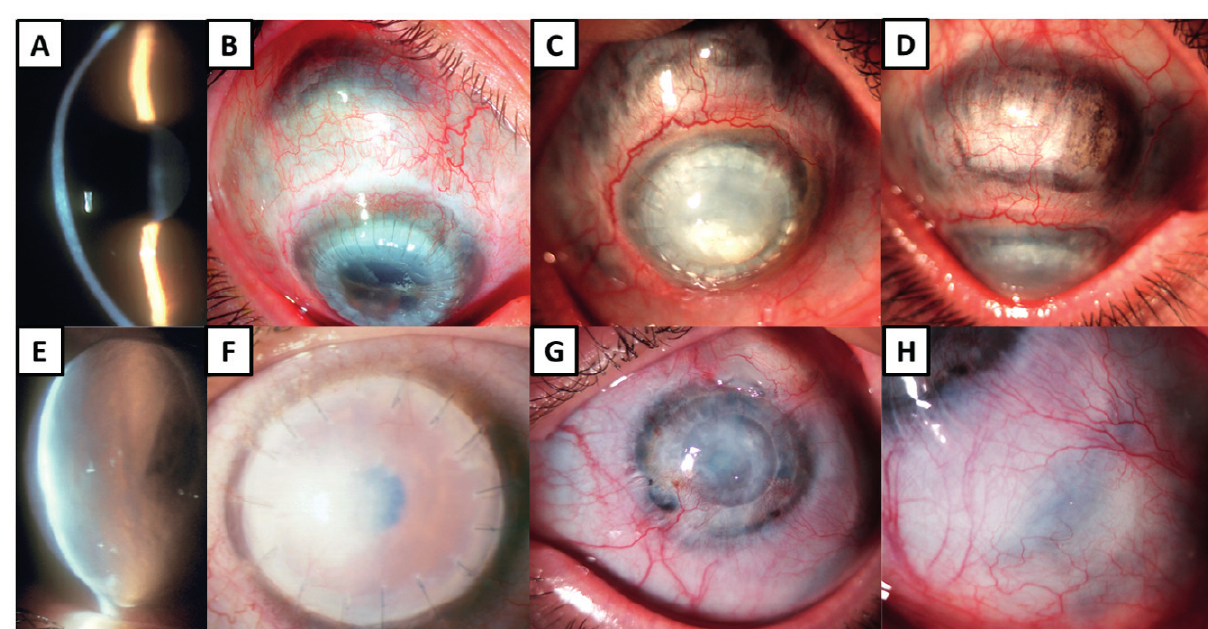
Fig. 1. Ocular findings in a patient with brittle cornea syndrome. (A) Narrow slit-beam view of the right cornea with ectasia (age 16.5 years), (B) right eye after tectonic penetrating keratoplasty, note blue sclerae superior from the corneal limbus (age 26.5), (C) opaque right graft with lipoid keratopathy and progression of scleral thinning, (D) in detail (age 42). (E) Acute hydrops in the left